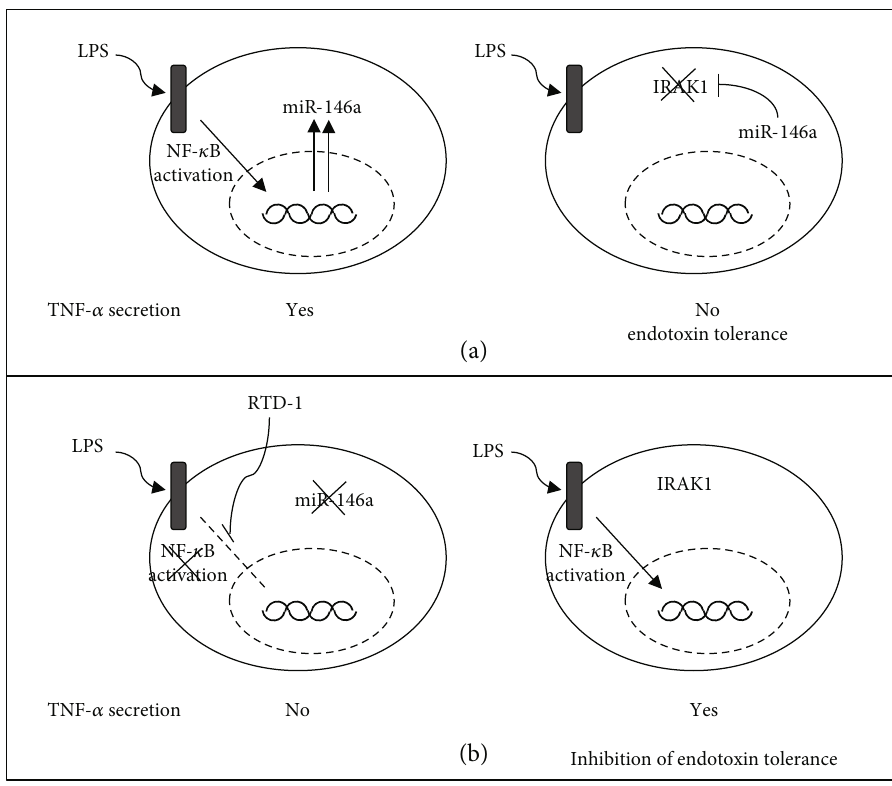
Figure 6: E ff ect of RTD-1 on miR-146a expression and endotoxin tolerance. (a) LPS stimulation of cells leads to activation of the NF- κ B pathway and miR-146a expression. IRAK1 is targeted by miR-146a which inhibits further stimulation of the TLR pathway. (b) RTD-1 inhibits activation of the NF- κ B pathway which leads to inhibition of miR-146a expression. Suppression of miR-146a expression stabilizes IRAK1 and enables a cellular proin fl ammatory response as observed by TNF- α secretion during secondary stimulation with